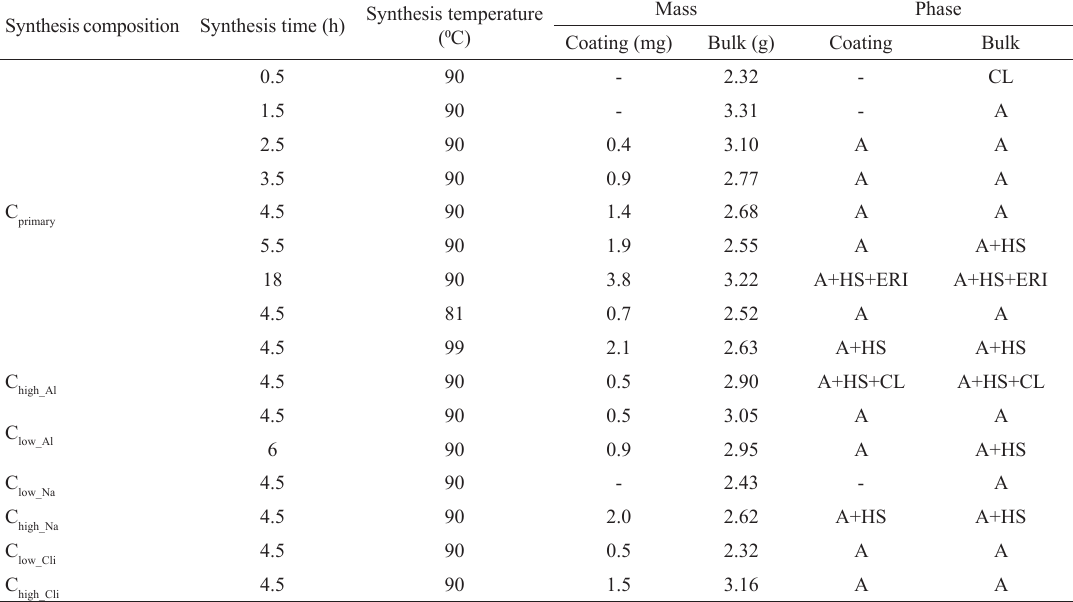
Table 1: Masses and phases of coatings and bulk phase solid materials obtained by conventional synthesis (A: zeolite A, HS: hydroxysodalite, ERI: erionite, CL: clinoptilolite). Synthesis temperature Synthesis composition Synthesis time (h)